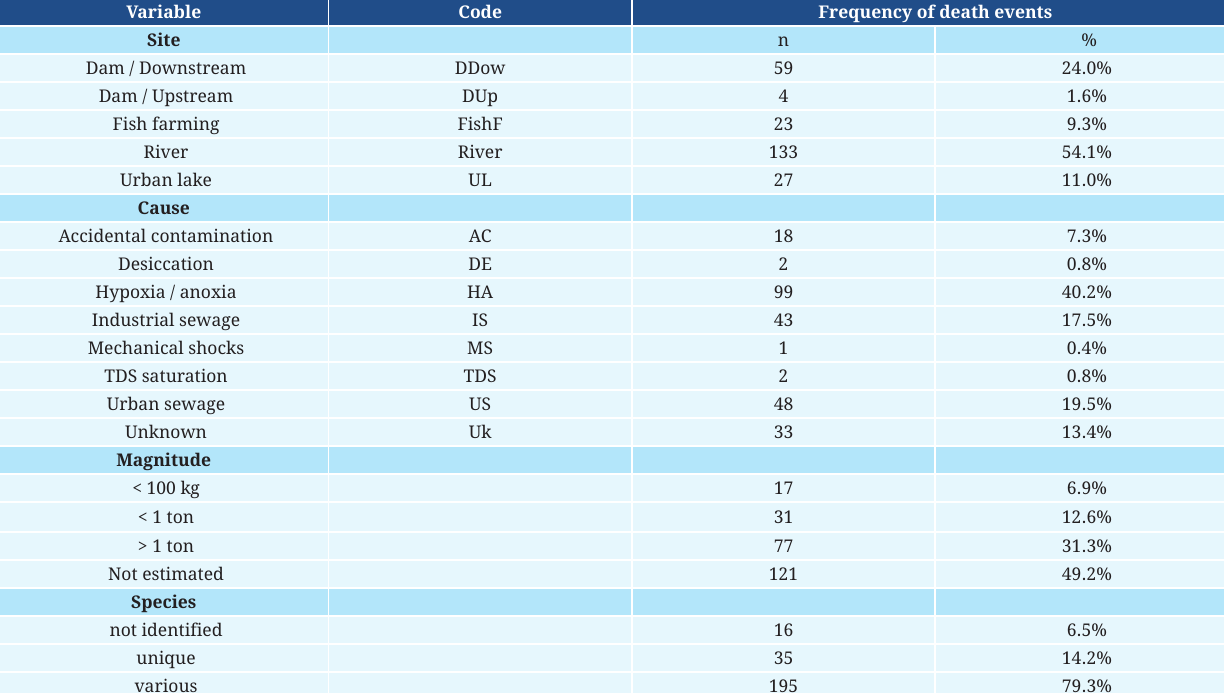
TABLE 1 | Frequency of fish mortality events recorded in Brazilian Hydrographic Basins, considering sites of death, causes, biomass affected and species, as reported by news (Google searches), between 2010 and